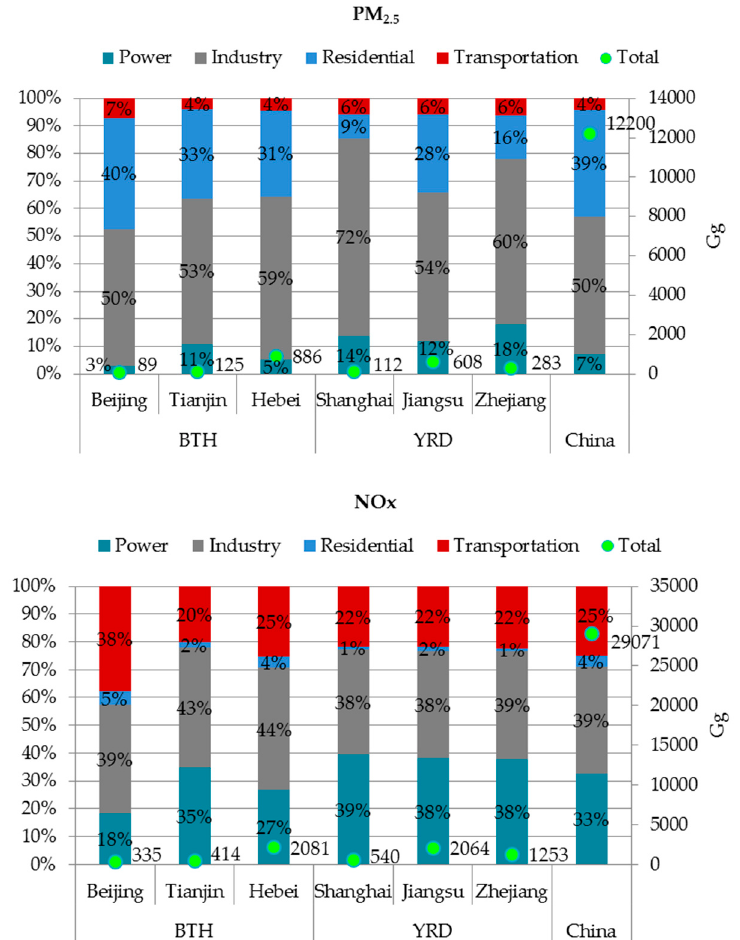
Figure A4. Main emissions of study regions and China in 2010 by sector (data source: Multi-resolution Emission Inventory for China (MEIC) database [85]).